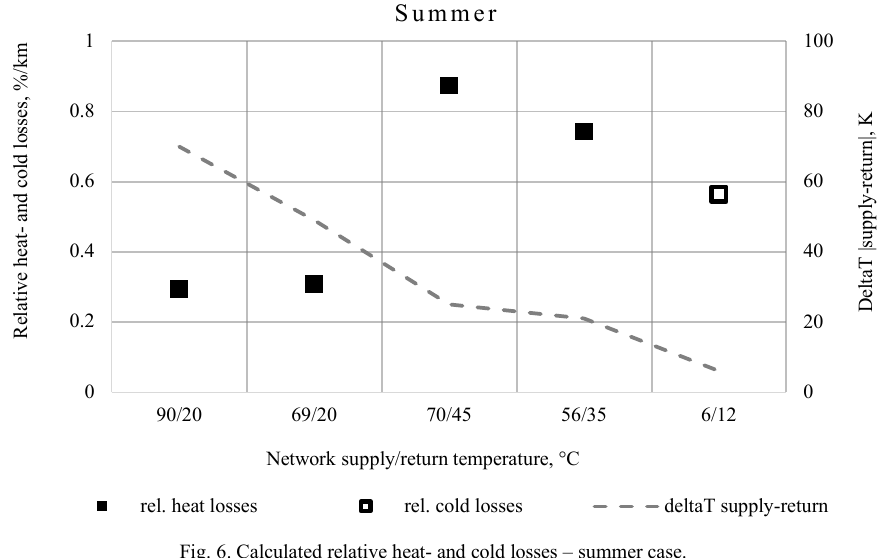
Fig. 6. Calculated relative heat- and cold losses – summer